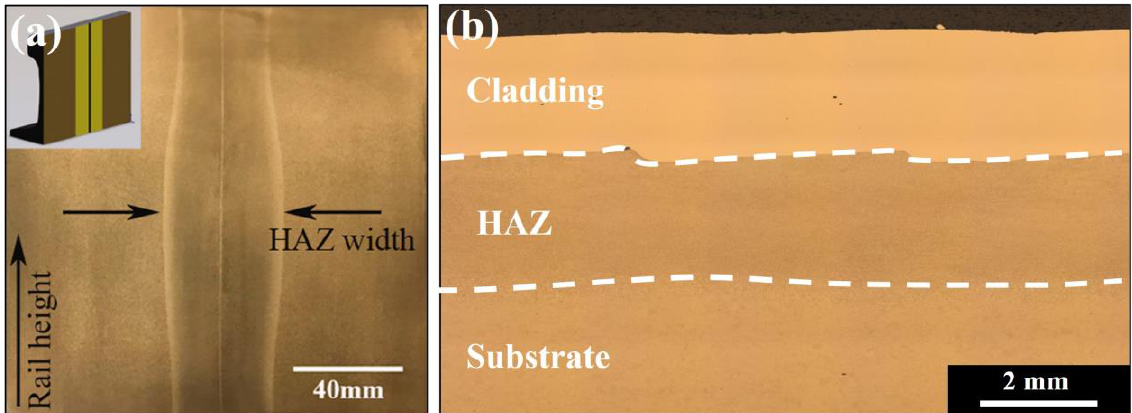
Figure 2. Generation of HAZ after ( a ) Flash-butt welding by Micheletto et al. [17] and ( b ) laser metal deposition.